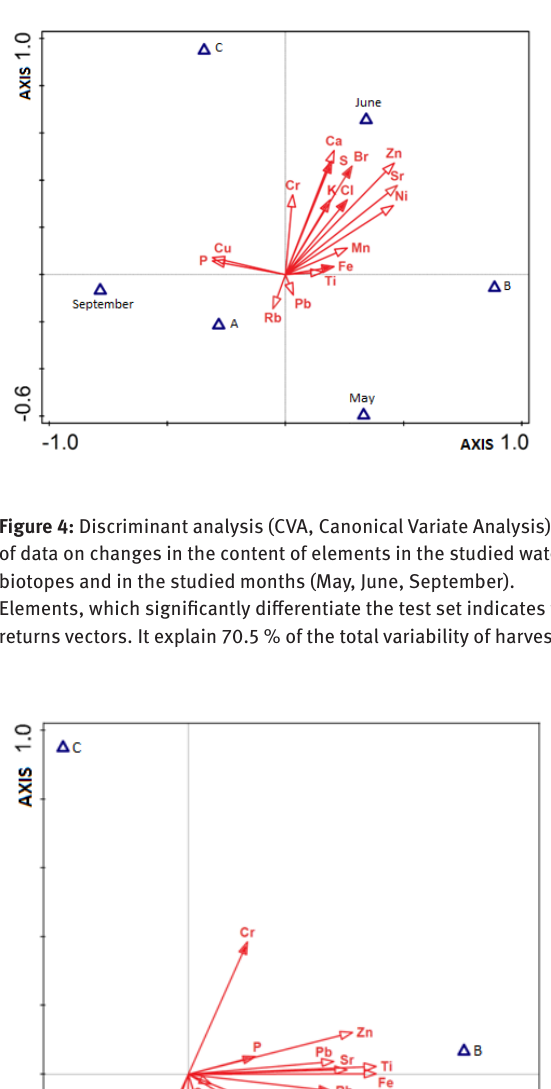
data explain 75.5% of the total variability.